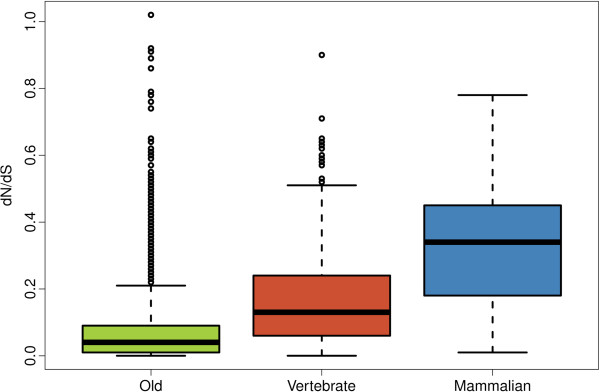
Non-synonymous to synonymous substitution rate ratio (dN/dS) for protein domains of different age. Old: 12,076 domains, Vertebrate: 521 domains, Mammalian: 47 domains. dN and dS were calculated for human and mouse orthologous genes, domains with unreliable dN or dS estimates were not considered (domain length < 60 amino acids or dN > 0.5 or dS >2). Differences between each pair of age classes were statistically significant (Kolmogorov-Smirnov test, p-value < 10-5). The area within the box contains 50% of the data; horizontal line is the median; outliers (5%) are represented as small circles.